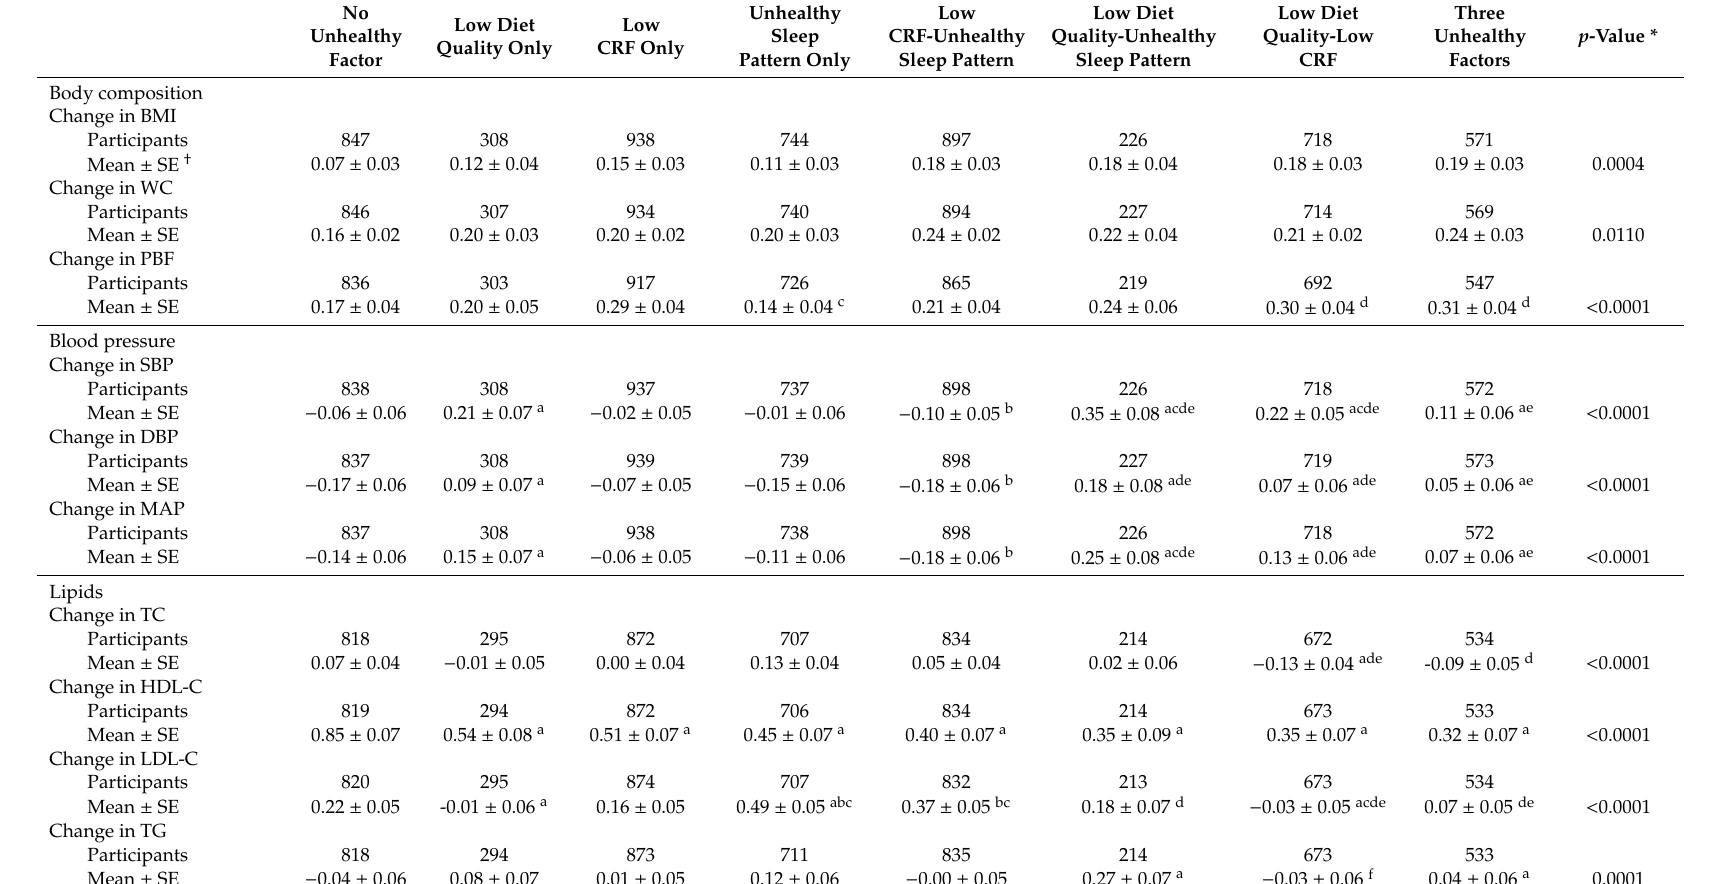
Table 4. Combination of three healthy factors and changes in cardiometabolic risk factors in